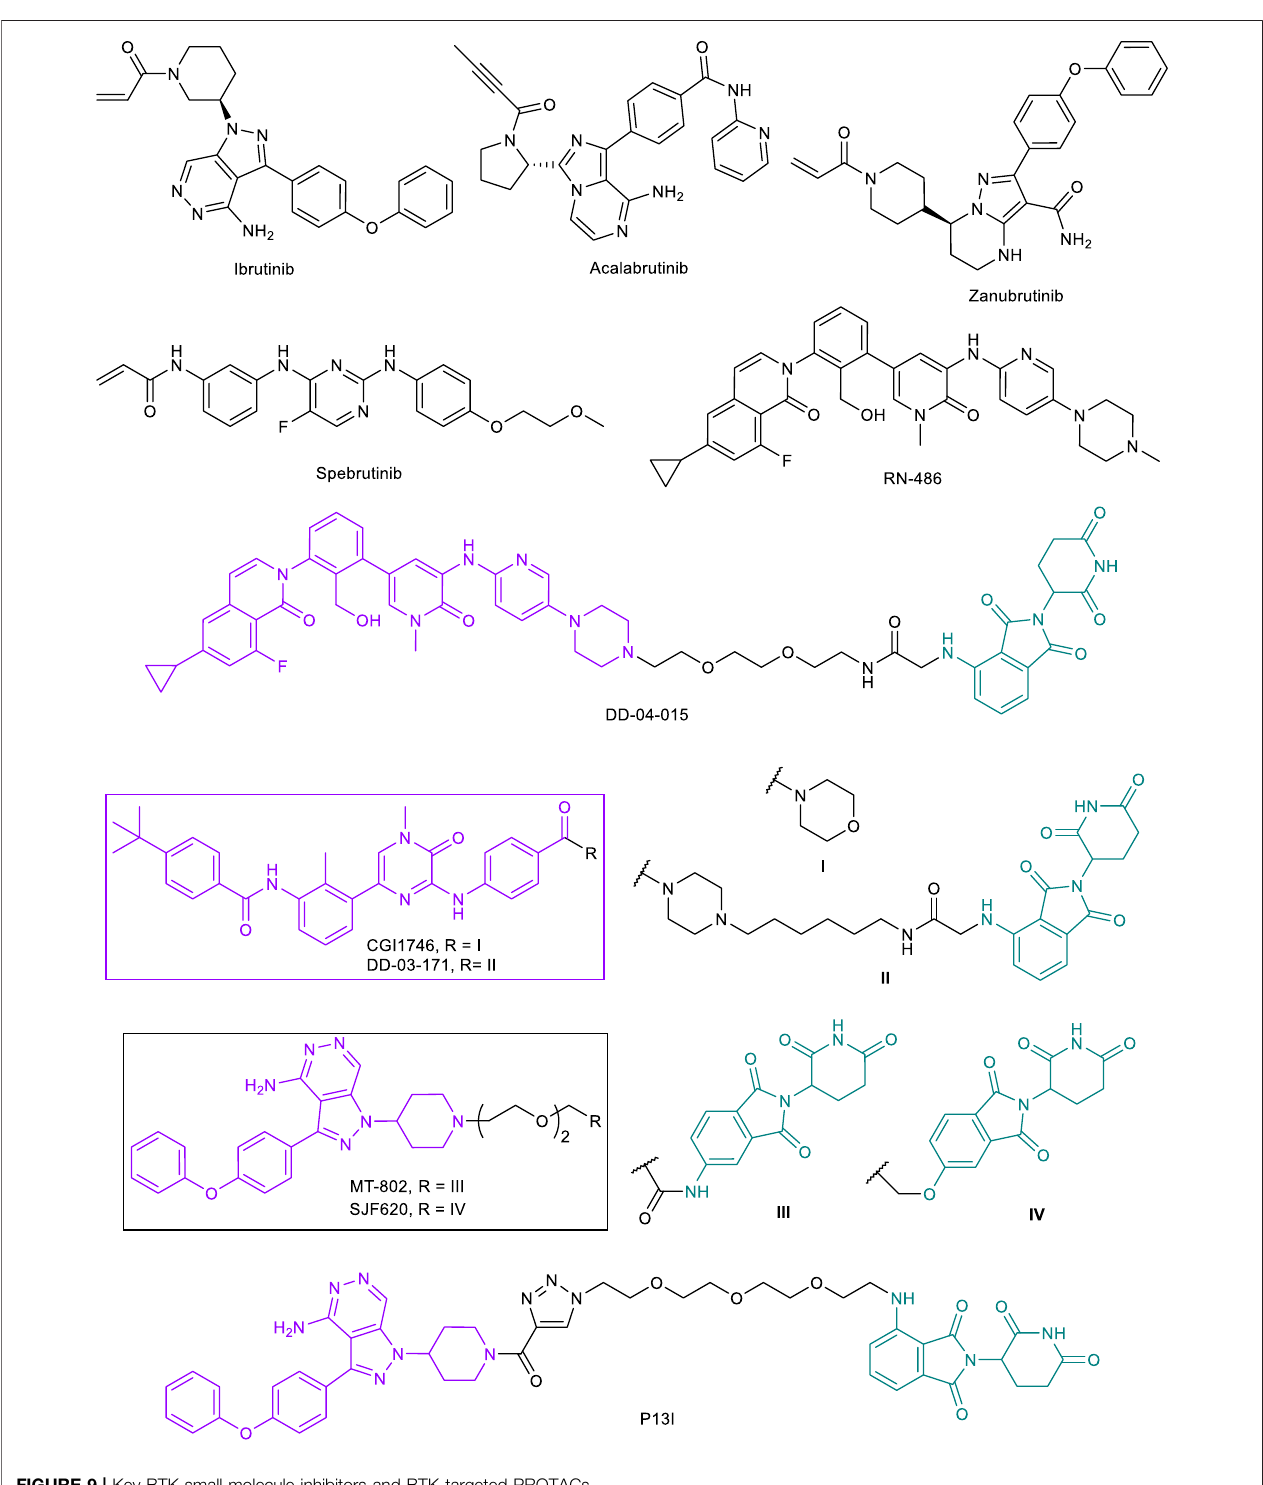
FIGURE 9 | Key BTK small molecule inhibitors and BTK-targeted PROTACs.